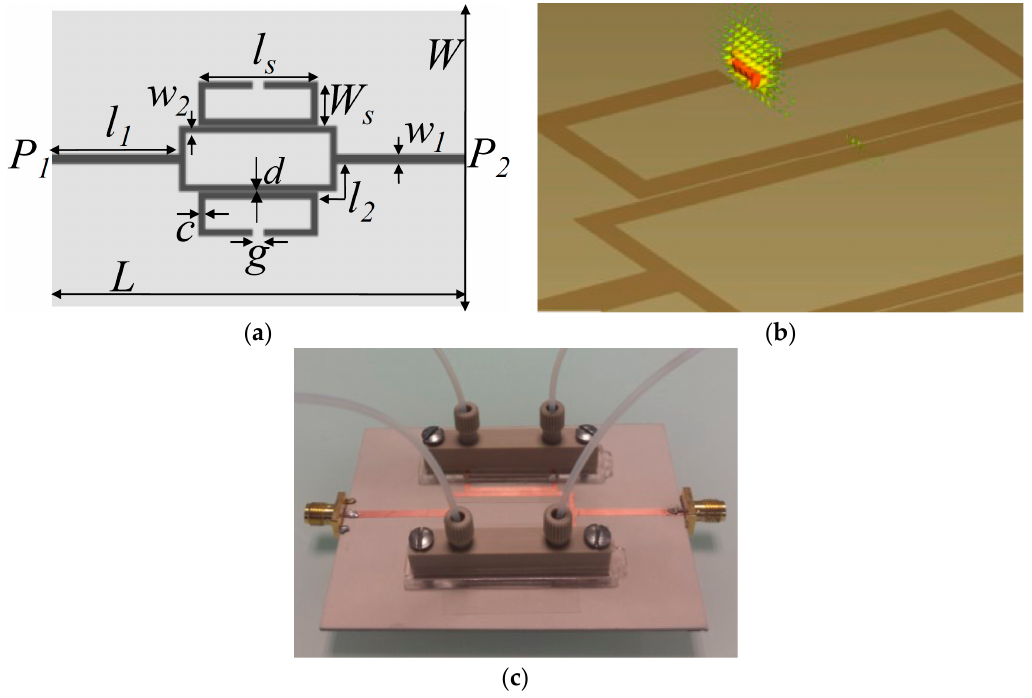
Figure 6. ( a ) Geometry of the splitter/combiner configuration: L = 86 mm, W = 62 mm, l 1 = 27 mm, w 1 = 2.22 mm, ls = 25 mm, Ws = 9 mm, c = 1.4 mm, g = 2.4 mm, d = 0.2 mm, l 2 = 9.21 mm, w 2 = 1.34 mm. ( b ) Electric field distribution at SRR resonance (the region with highest intensity at SRR gap is shown). ( c ) Fabricated prototype of metamaterial inspired microfluidic chemical sensor (redrawn from [39]).